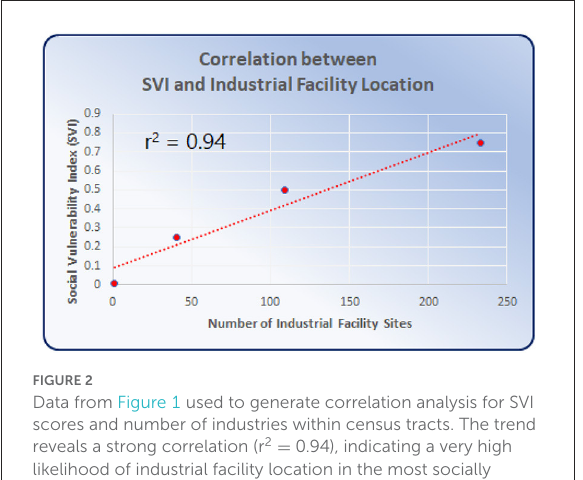
FIGURE2 Data from Figure 1 used to generate correlation analysis for SVI scores and number of industries within census tracts. The trend reveals a strong correlation (r 2 = 0.94), indicating a very high likelihood of industrial facility location in the most socially vulnerable census tracts, compared with surrounding